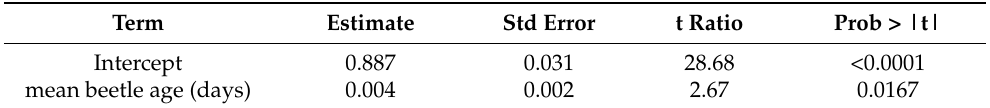
Figure 3. Scatterplot of the number of eggs per beetle per day vs. mean beetle age (days) for experiment 1. Points represent individual measurements. The use of an oviposition grid is indicated in blue (grid) and red (no grid). Oviposition duration is indicated with symbols • = 2 days, (cid:78) = 4 days and (cid:4) = 8 days. Table 3. Parameter estimates, standard error and significance level (t ratio and p -value) for multiple linear regression model of hatching (%) for experiment 1.